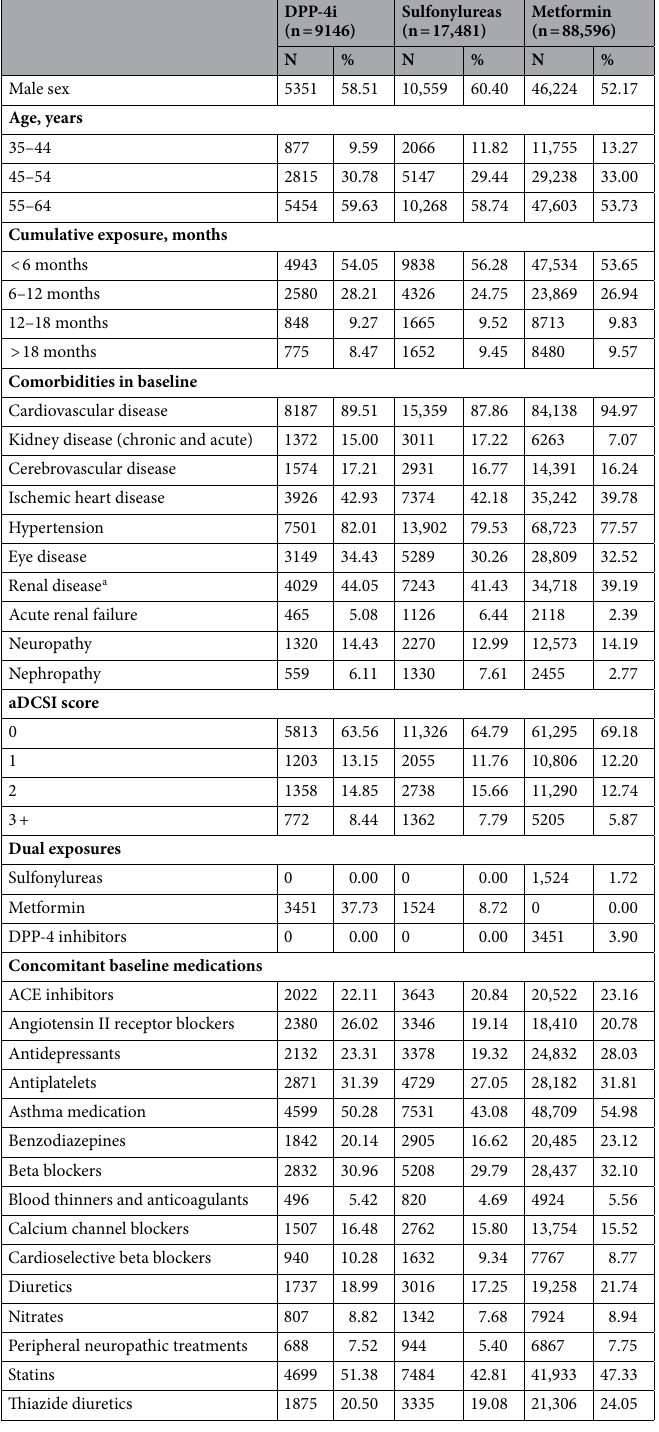
Table 1. Baseline demographics and medical characteristics. aDCSI adapted diabetes complications severity index. a Includes diseases of kidneys, ureters, and bladders; inclusive of acute renal